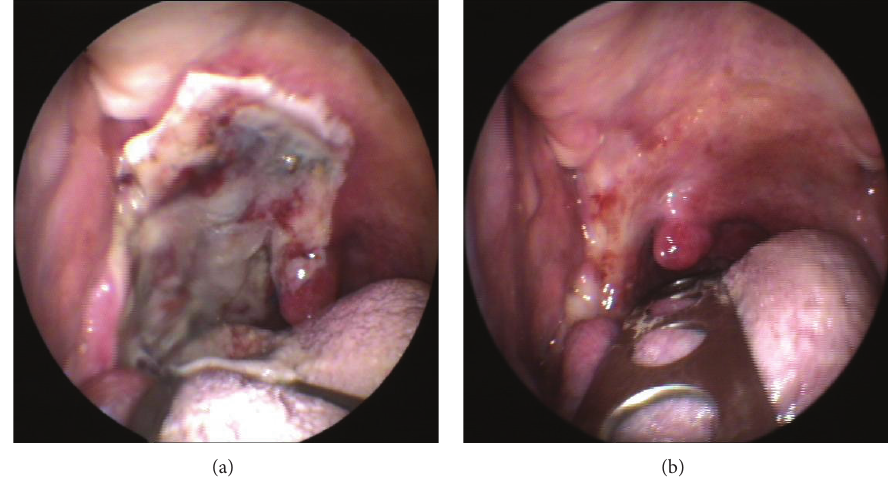
Figure 4: Postoperative anterior pharyngoscopy. (a) Immediate surgical scar at 5th postoperative day. Patient was on full oral diet. (b) Late scar. Note the marked lateralization of the uvula due to the contraction of the